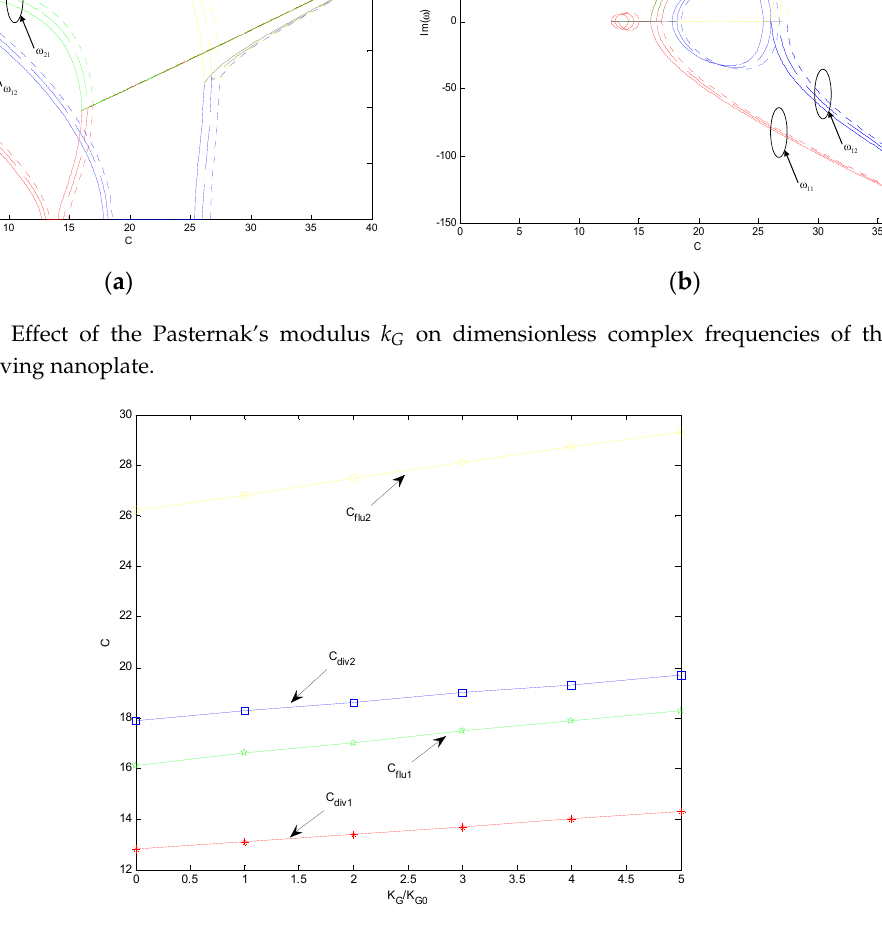
Figure 8. Effect of the Pasternak’s modulus k G on the flutter and divergence speed of the axially-moving nanoplate.